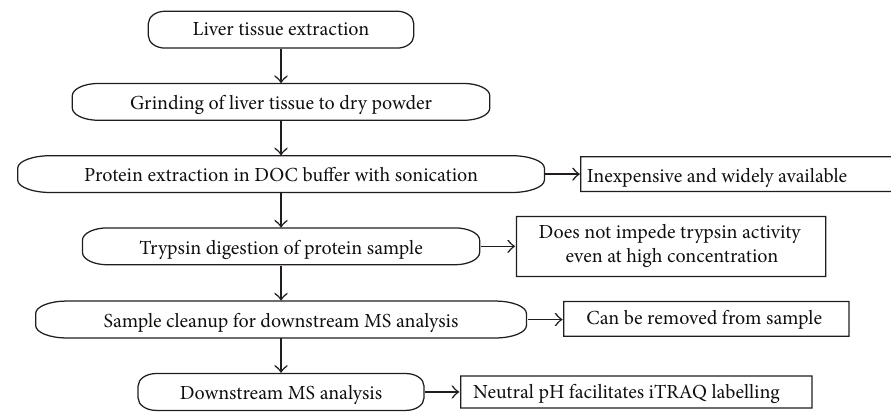
Figure 7: An overview of advantages of DOC as a protein extraction buffer for proteomic